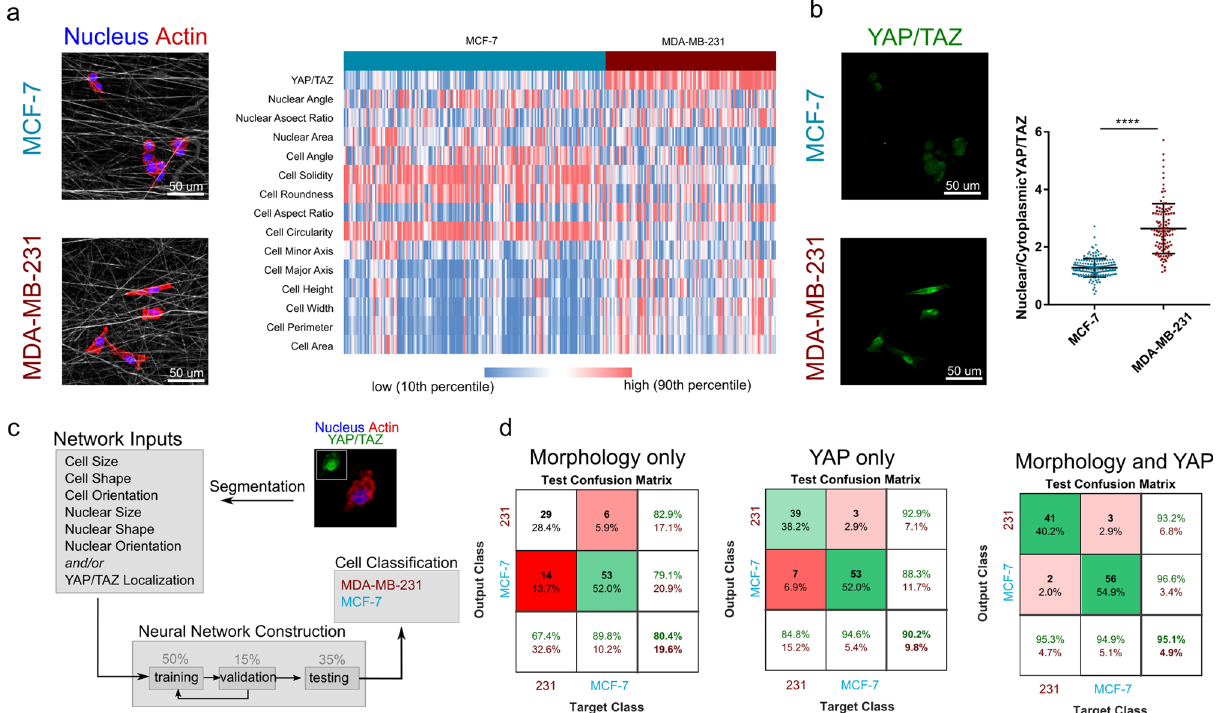
Figure 6. ( a ) Non-invasive and invasive cancer cells showed different, yet heterogeneous, morphologies on non-aligned fibrous templates, and this difference was highlighted by ( b ) different YAP/TAZ states. ( c ) A neural network was constructed to classify cells as invasive or non-invasive based on morphology and/or YAP/ TAZ levels. ( d ) Using morphology to classify cells resulted in 80.4% accuracy, while YAP/TAZ predicted cell classification with 90.2% accuracy. Using both morphology and mechanosensing increased accuracy to 95.1%, highlighting the utility of exploiting both morphology and mechanosensing in invasive cancer cells